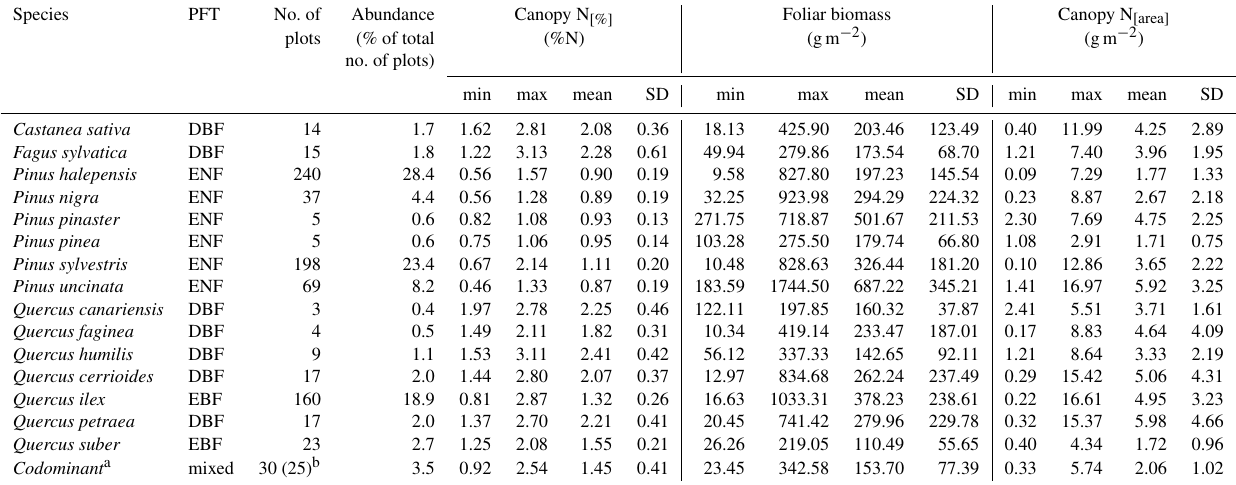
Table 1. Descriptive analysis of canopy nitrogen (N) concentration (N [ % ] , %N), foliar biomass (gm − 2 ) and canopy N content (N [ area ] , grams of N per square metre of ground area, gm − 2 ) by tree species. PFT is plant functional type, DBF is deciduous broadleaf forest, EBF is evergreen broadleaf forest, ENF is evergreen needleleaf forest, mixed is mixed forest, min is minimum, max is maximum, mean is average, and SD is standard deviation. a Codominant plots refer to the plots where two tree species were dominant in the canopy. b Foliar biomass data were lacking for five of the plots. Foliar biomass and canopy N content statistics are thus measured on a restricted number of plots.